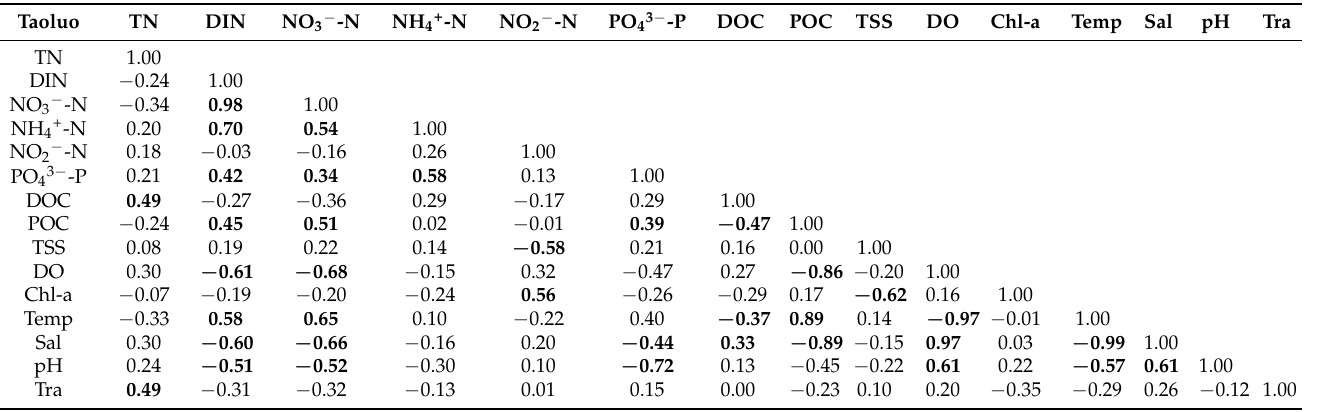
Table 5. Pearson correlation coefficient between the water quality parameters based on the data from the stations at Taoluo. The bold numbers indicate a statistically significant correlation ( p < 0.05). The abbreviations are the same in Table